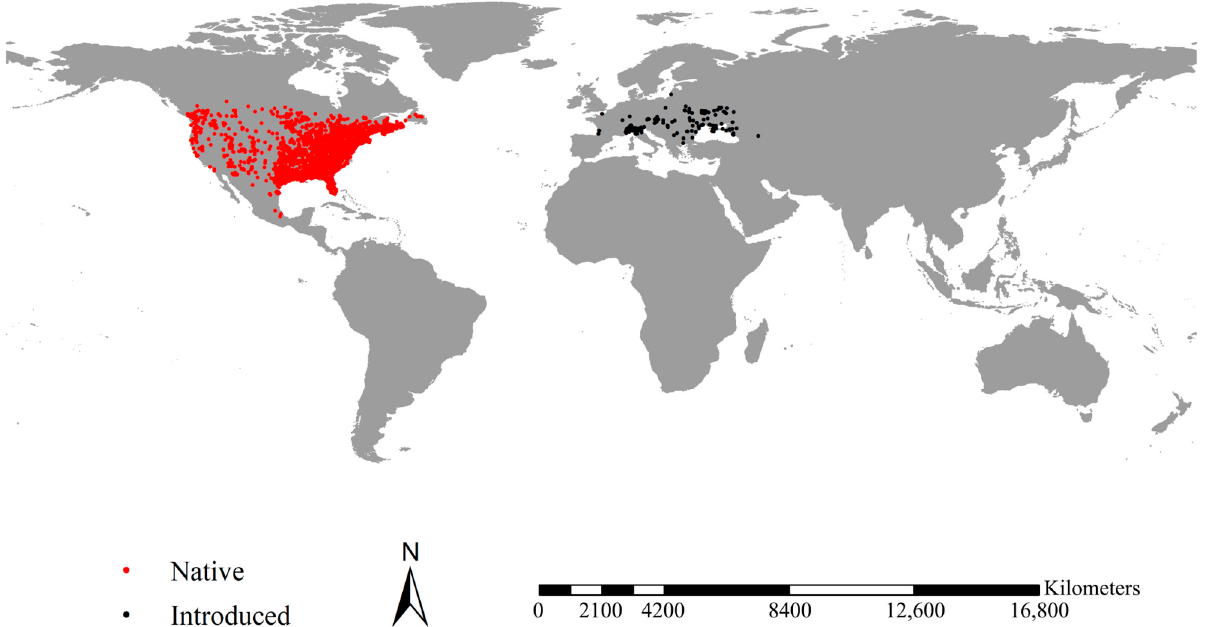
Figure 1. Occurrence records of the fall webworm. Black and red points represent the occurrence of the fall webworm in North America and the fall webworm in Europe, respectively. After spatial sparsification, we obtained a total of 3661 records, including 3465 records of the fall webworm in North America and 196 records of the fall webworm in Europe.